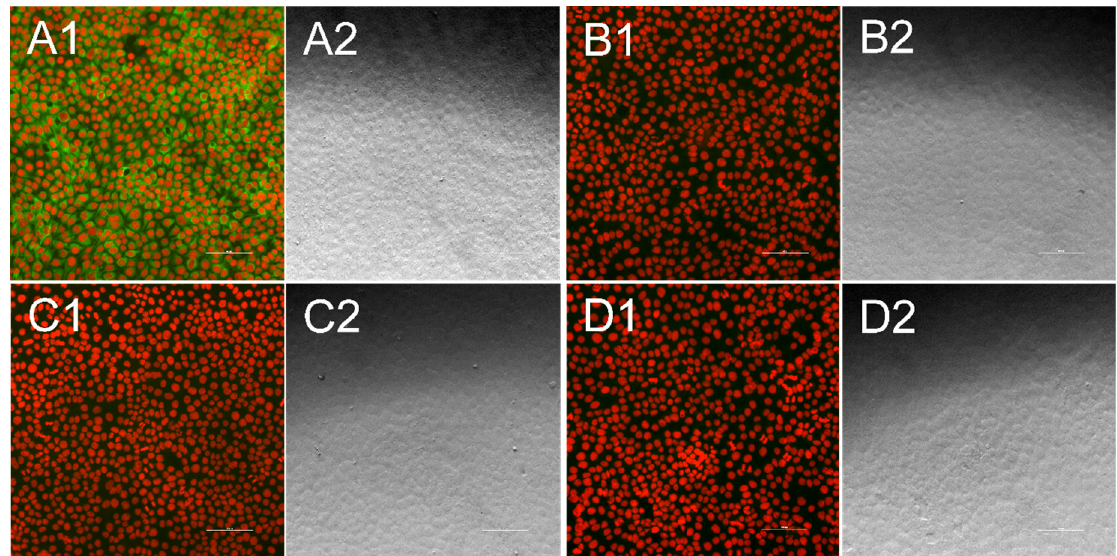
Figure 2. Indirect immunofluorescence test for Bungowannah pestivirus (BuPV)-specific antibodies. Each fluorescence picture (1) is presented alongside a bright field picture, that was taken at the same position (2). Cell nuclei appear in red, while antibodies against BuPV are stained in green. When antibodies were present in the sample they bound to PK15 cells infected with the BuPV isolate ( A ), while no green fluorescence could be seen when antibody-positive samples were tested against uninfected cells ( B ). Antibody-negative serum sample neither showed significant interaction with infected cells ( C ) nor with uninfected cells ( D ). Bar is 100 µm.